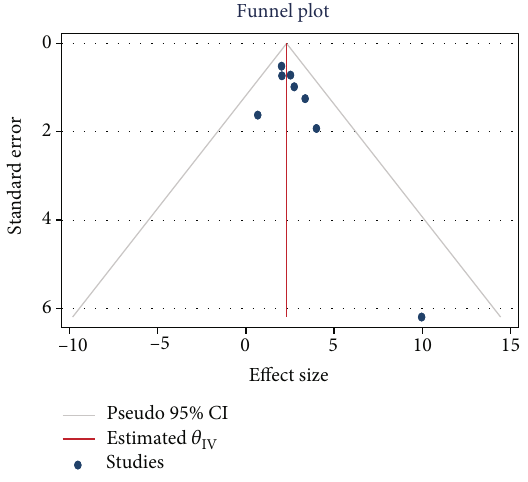
Figure 5: A funnel plot for assessing publication